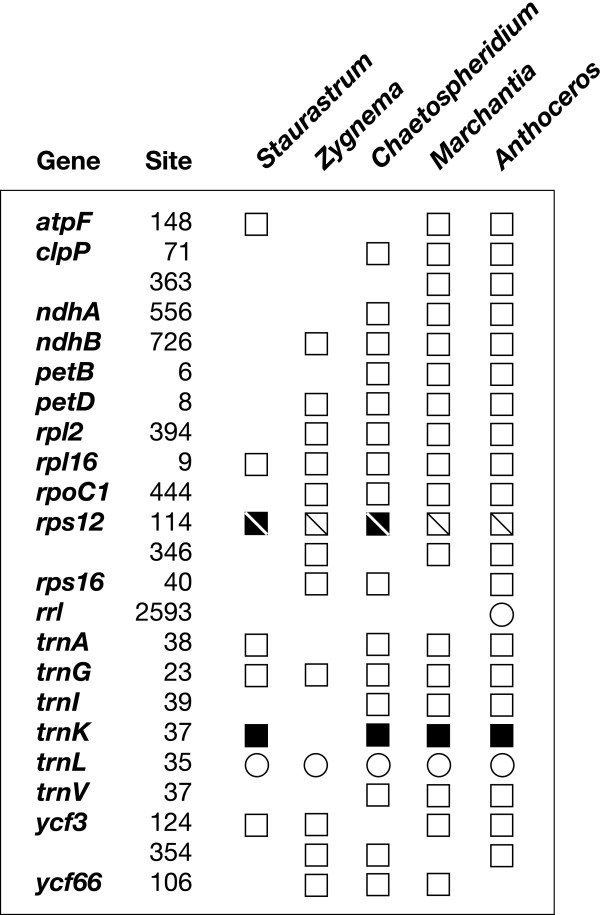
Distributions of introns in streptophyte cpDNAs. Circles denote the presence of group I introns, and squares denote the presence of group II introns. Divided squares represent trans-spliced group II introns. Open symbols denote the absence of intron ORFs, whereas filled symbols denote their presence. Intron insertion sites in protein-coding and tRNA genes are given relative to the corresponding genes in Mesostigma cpDNA; the insertion site in rrl is given relative to the Escherichia coli 23S rRNA. For each insertion site, the position corresponding to the nucleotide immediately preceding the intron is reported. Note that rps16 is lacking in Marchantia cpDNA and that the rrl intron at position 2593 is absent from all completely sequenced land plant cpDNAs, with the exception of Anthoceros cpDNA. The intron data were taken from the following accession numbers: Staurastrum, [GenBank:AY958085]; Zygnema, [GenBank:AY958086]; Chaetosphaeridium, [GenBank:NC_004115]; Marchantia, [GenBank:NC_001319]; and Anthoceros formosae [GenBank:NC_004543].